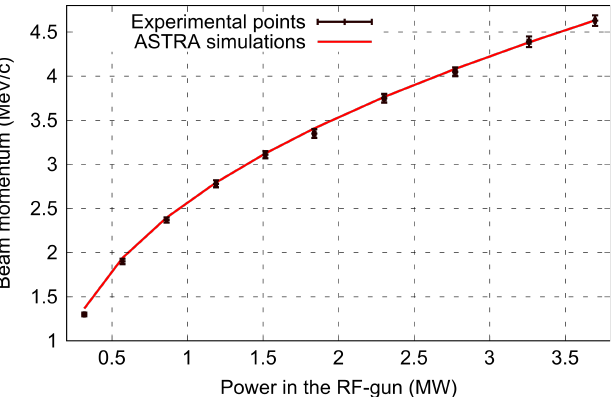
Figure 7. Measured beam momentum vs. RF power. The momentum measurement was done using the first vertical corrector magnet. The RF phase was fixed at − 20deg relative to zero-crossing. The measurement points are compared with ASTRA simulations.